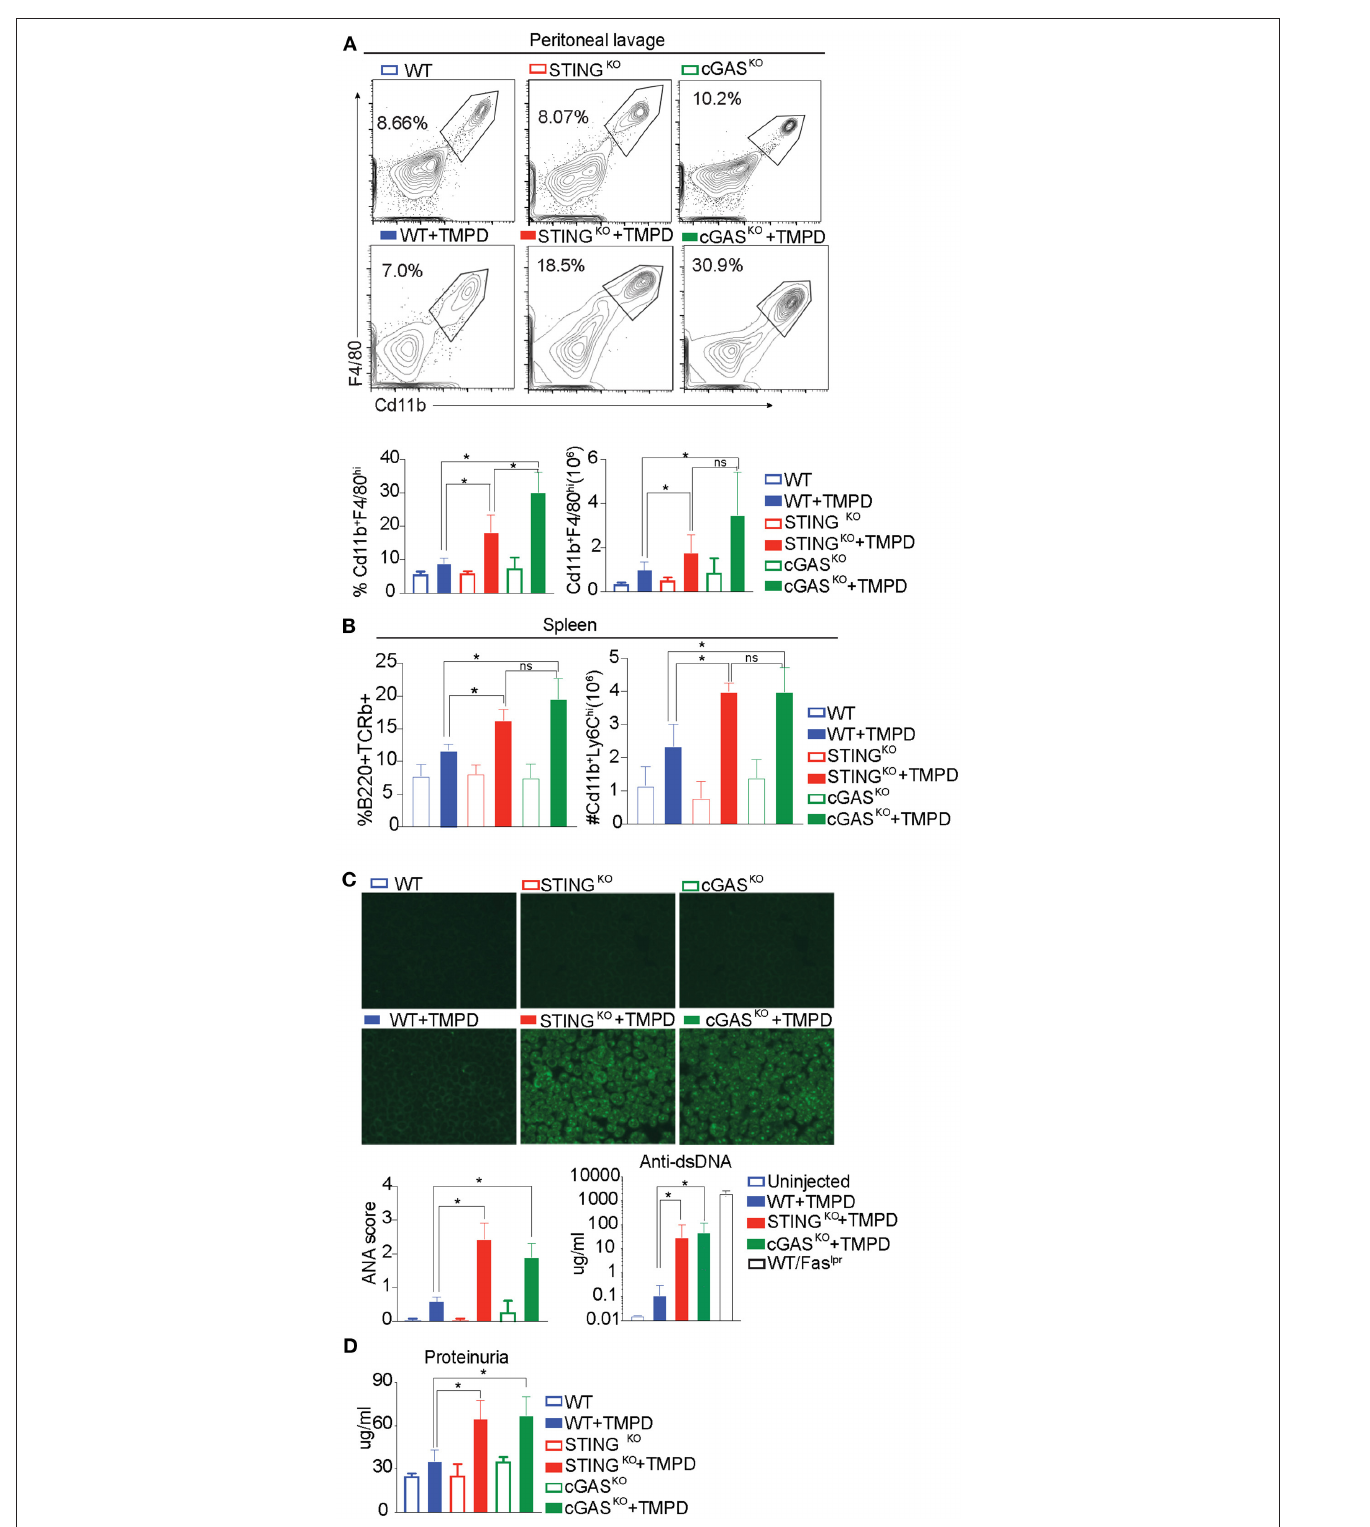
FIGURE 2 | STING and cGAS deficiency exacerbate disease in chronic model of TMPD induced autoimmunity. 12–16 week-old female WT, STING KO or cGAS KO mice were either uninjected (open bars, n = 5) or injected with 500 ul of TMPD (closed bars, n = 15) were analyzed from two independent experiments. (A) 6 months